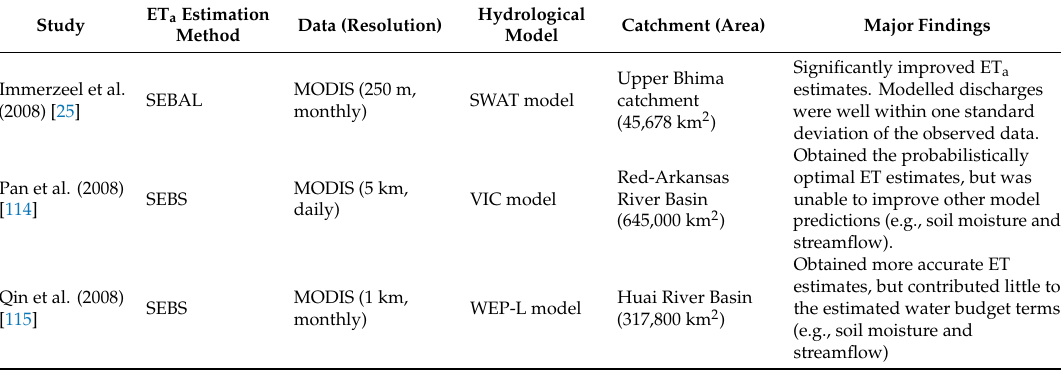
Table 2. Relevant studies on improving hydrological simulations using satellite-based ET a